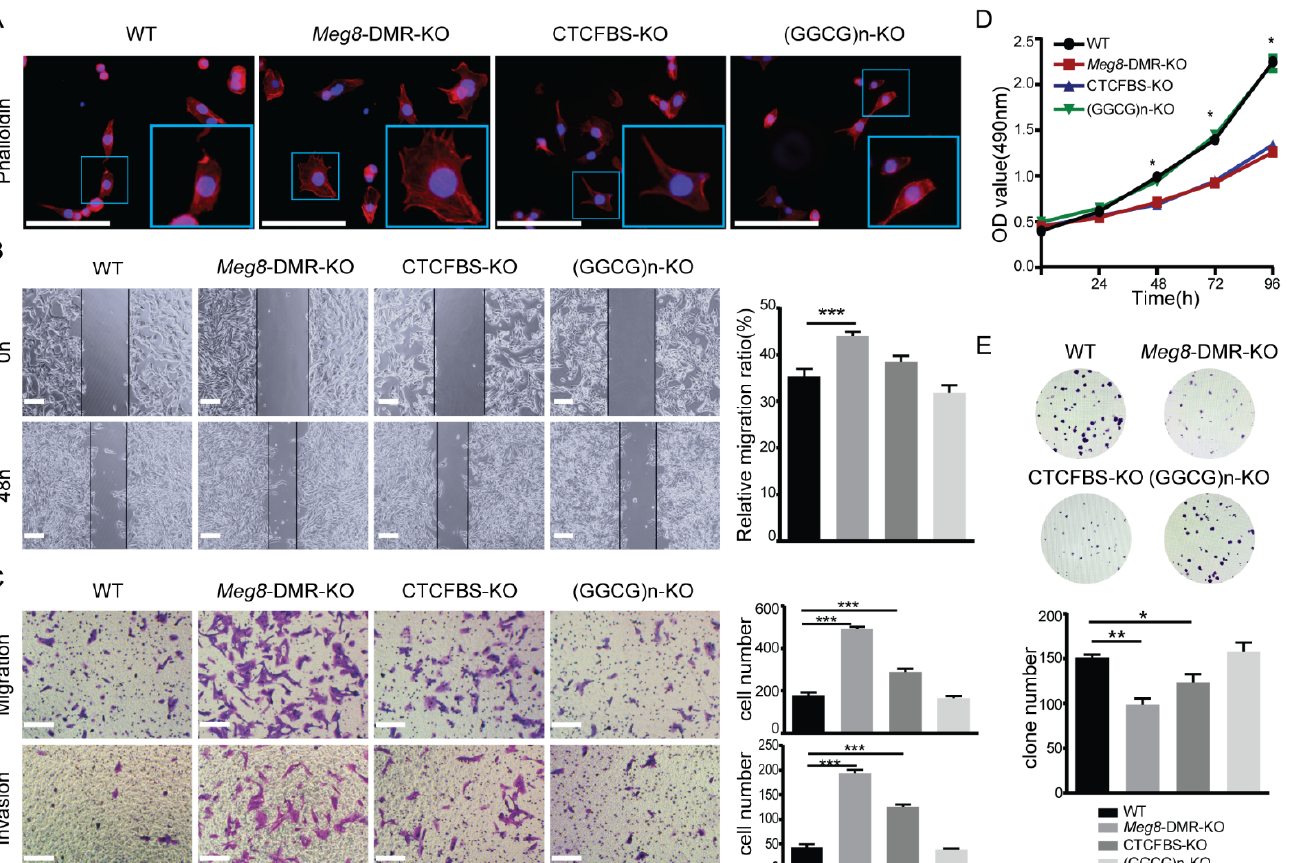
Figure 4. DEGs Functional Analysis of the Meg8 -DMR deletion cell lines. ( A – C ) Top 20 of KEGG pathway enrichment of genes differentially expressed in Meg8 -DMR-KO, CTCFBS-KO, and (GGCG)n-KO. ( D ) Top 10 GO terms of cellular component (CC) of GO enrichment analysis of dif- ferentially expressed genes in Meg8 -DMR-KO, CTCFBS-KO and (GGCG)n-KO.